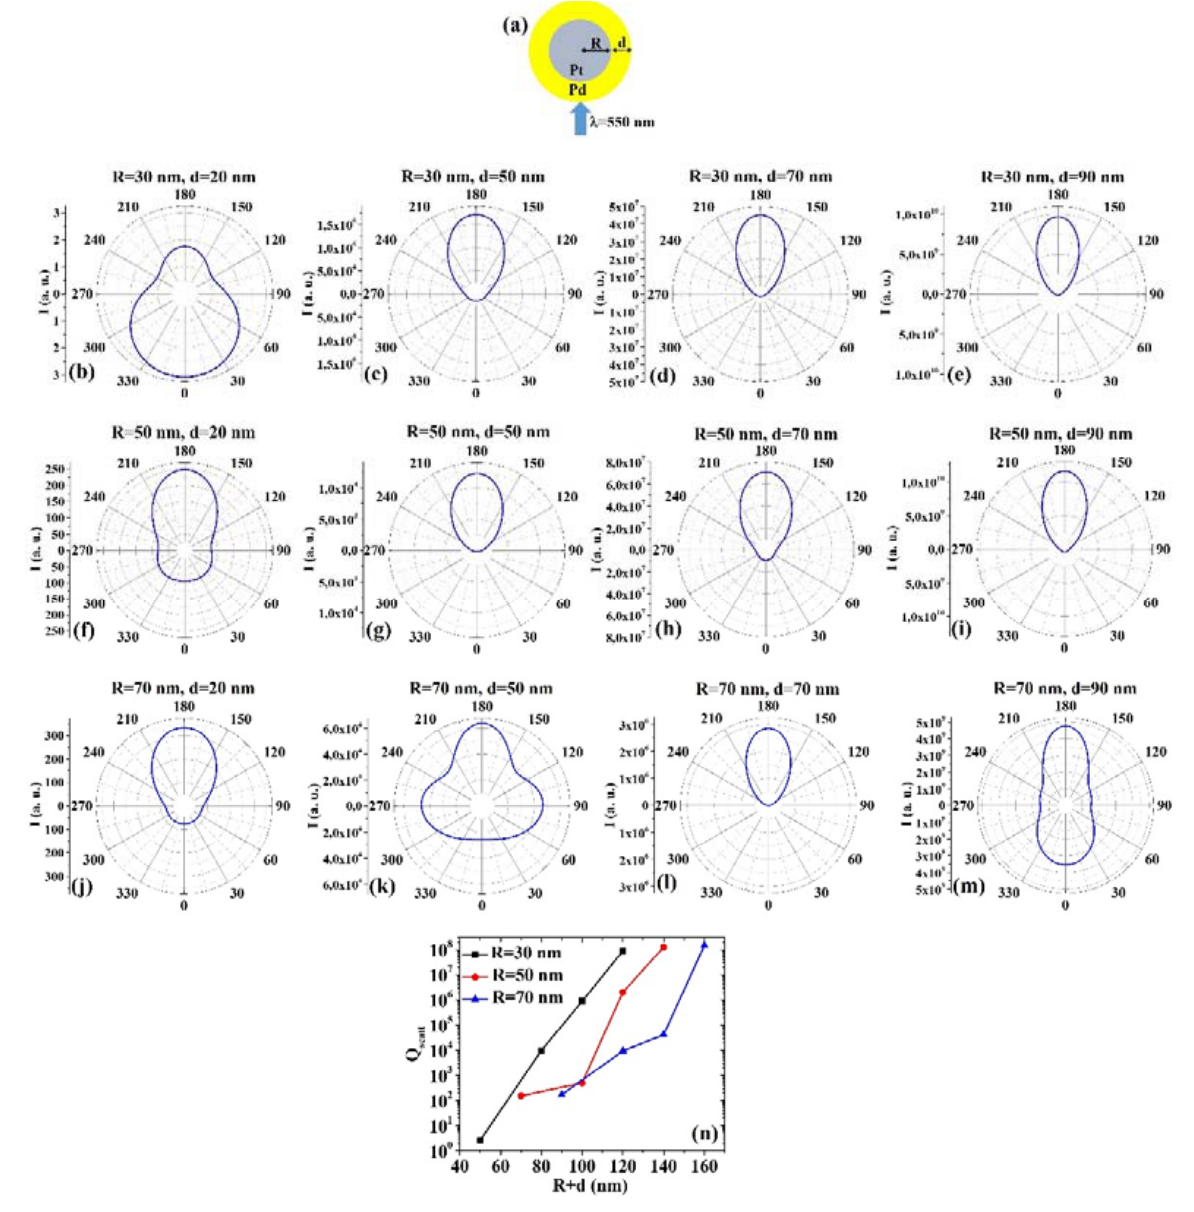
Figure 10. ( a ) Scheme of the structure of the simulated Pt/Pd core/shell spherical particle with core radius R and shell width d and electromagnetic radiation of wavelength λ = 550 nm impinging on the particle from 0 ◦ . ( b – m ) Calculated polar diagrams for the intensity of the scattered light from the Pt/Pd core/shell spherical particle changing the Pt core radius R and the Pd shell width: ( b – e ) R = 30 nm and d = 20 nm ( b ), d = 50 nm ( c ), d = 70 nm ( d ), d = 90 nm ( e ); ( f – i ) R = 50 nm and d = 20 nm ( f ), d = 50 nm ( g ), d = 70 nm ( h ), d = 90 nm ( i ); ( j – m ) R = 70 nm and d = 20 nm ( j ), d = 50 nm ( k ), d = 70 nm ( l ), d = 90 nm ( m ). ( n ) Calculated scattering efficiency for the light (wavelength λ = 550 nm) scattering process of the Pt/Pd spherical particle fixing the Pt core diameter (R = 30 nm black dots, R = 50 nm red dots, R = 70 nm blue dots) and increasing the Pd shell width d from 20 nm to 90 nm.